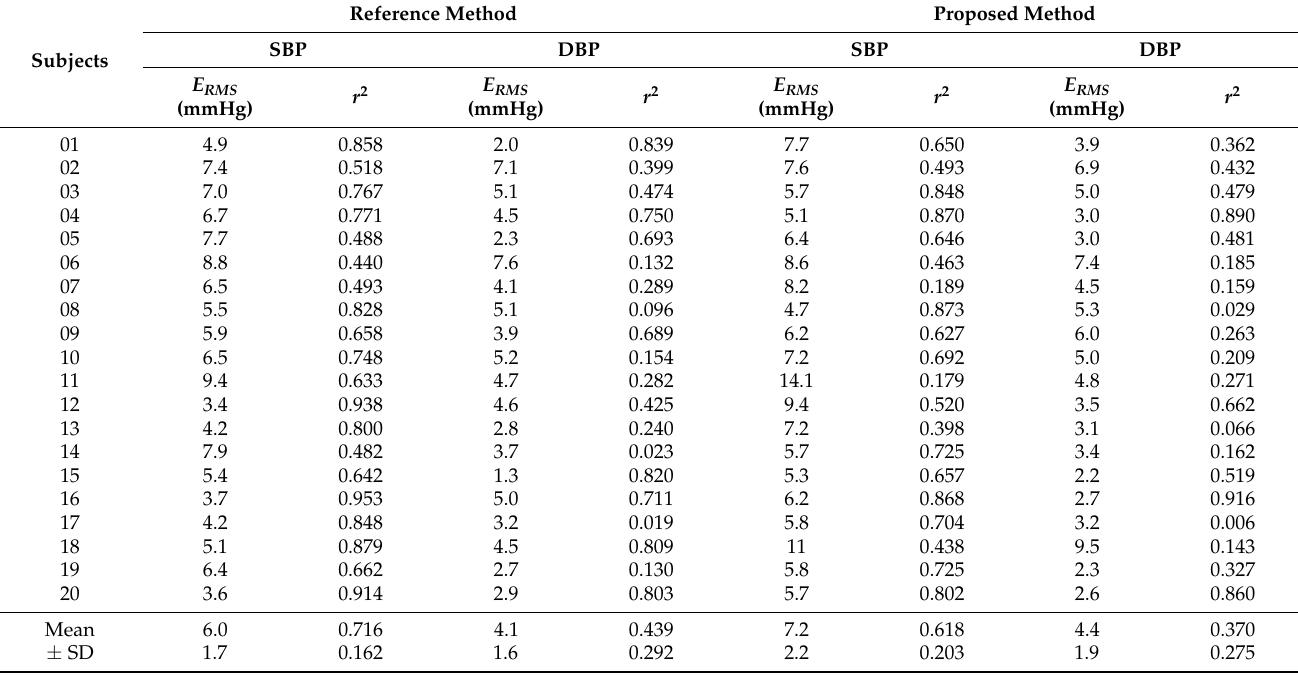
Table 5. Results of estimated systolic and diastolic blood pressures with Equation